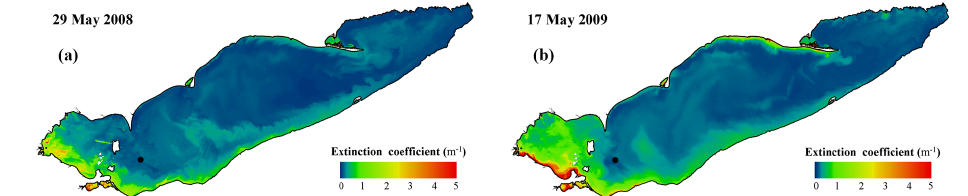
Figure 11. Temporal and spatial variation of K d in Lake Erie during May of 2 consecutive years: 2008 and 2009. Location of the NDBC station is shown on the map as a solid